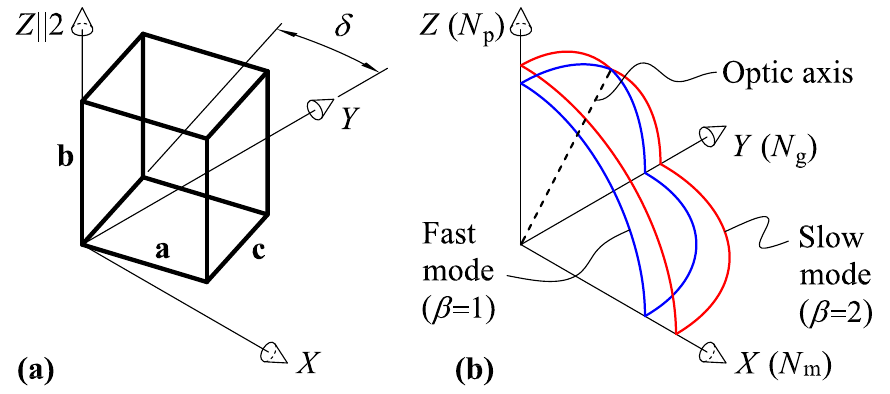
Figure 1. Dielectric properties of the KYW and KGW monoclinic crystals: ( a ) crystal’s unit cell; ( b ) refractive index surface cut-out. Z is the twofold symmetry axis; XY is the symmetry plane; optic axis (dashed line) is on the ZY